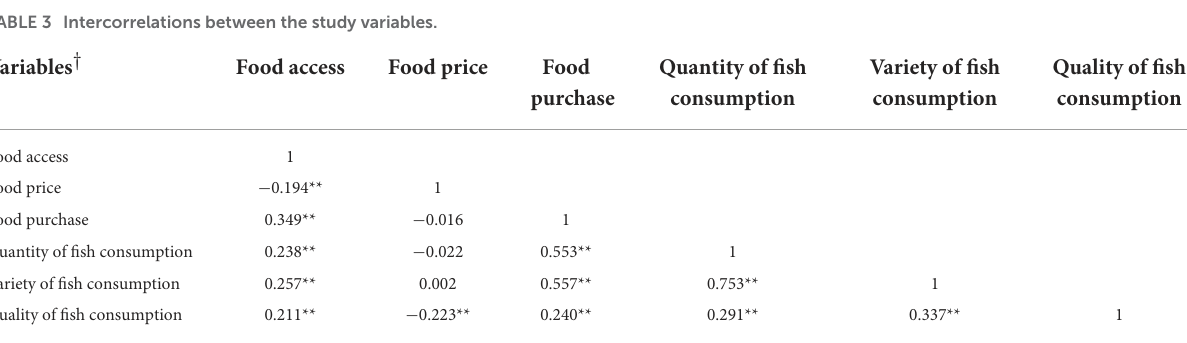
TABLE 3 Intercorrelations between the study